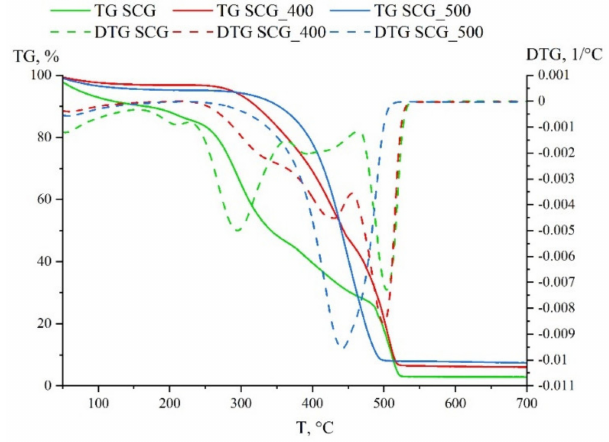
Figure 3. Thermal behaviour (TG and DTG curves) of spent coffee grounds (SCG) and biochars (SCG_400 and SCG_500) in air atmosphere (combustion conditions).